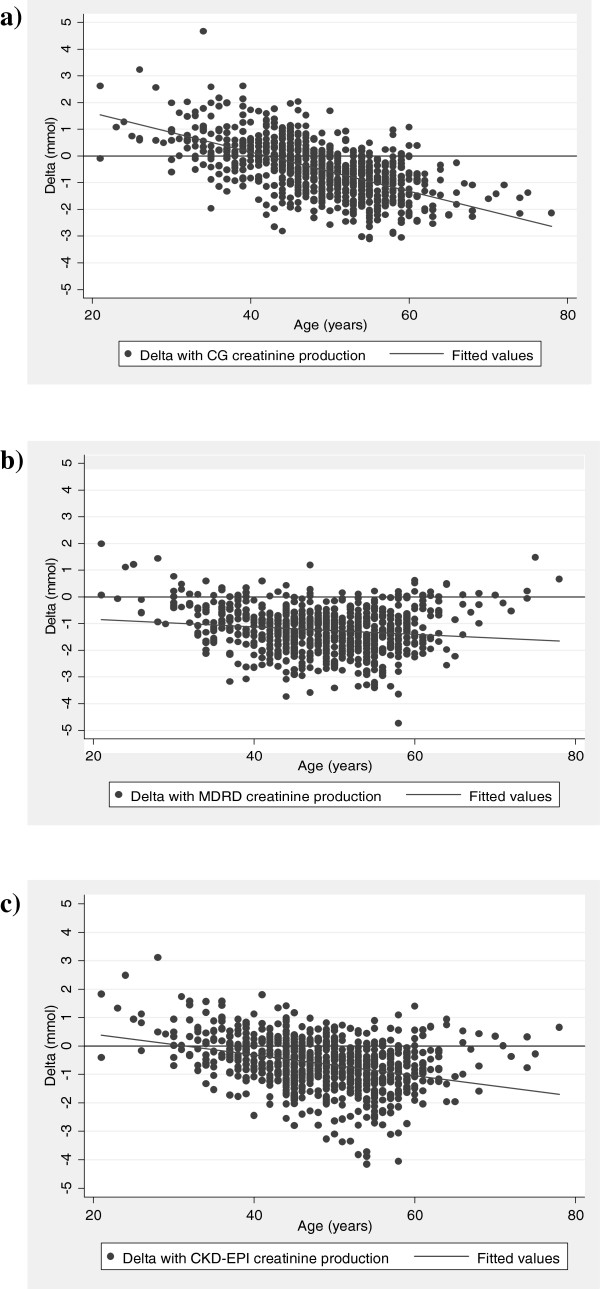
Association between the difference in estimated 24 hour creatinine production using Cockcroft-Gault, MDRD, CKD-EPI compared to the Rule formula regressed against age of the participant. a) Difference (delta) between 24 h creatinine production derived from Cockcroft-Gault and 24 h creatinine production from the Rule formula. b) Difference (delta) between 24 h creatinine production derived from MDRD and 24 h creatinine production from the Rule formula. c) Difference (delta) between 24 h creatinine production derived from CKD-EPI and 24 h creatinine production from the Rule formula.